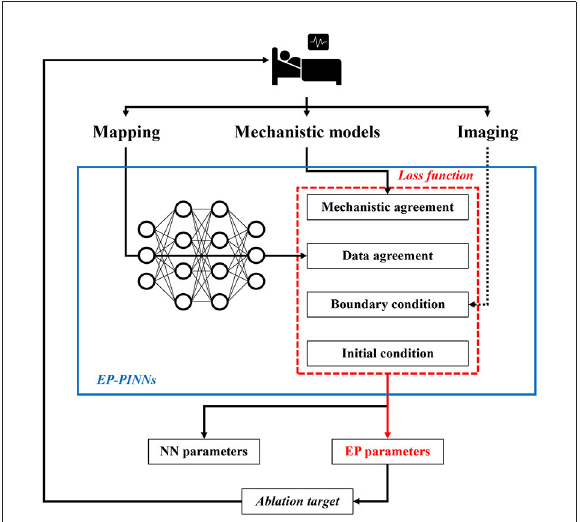
FIGURE1 Potential future application of EP-PINNs. EP-PINNs use a neural network that integrates mechanistic models with its associated biophysical laws as constraints, while simultaneously fitting the observed mapping data. The estimated electrophysiological parameters can be used to identify ablation targets, thereby facilitating personalized therapy. *The dotted line highlights potential future additions of other data sources such as cardiac